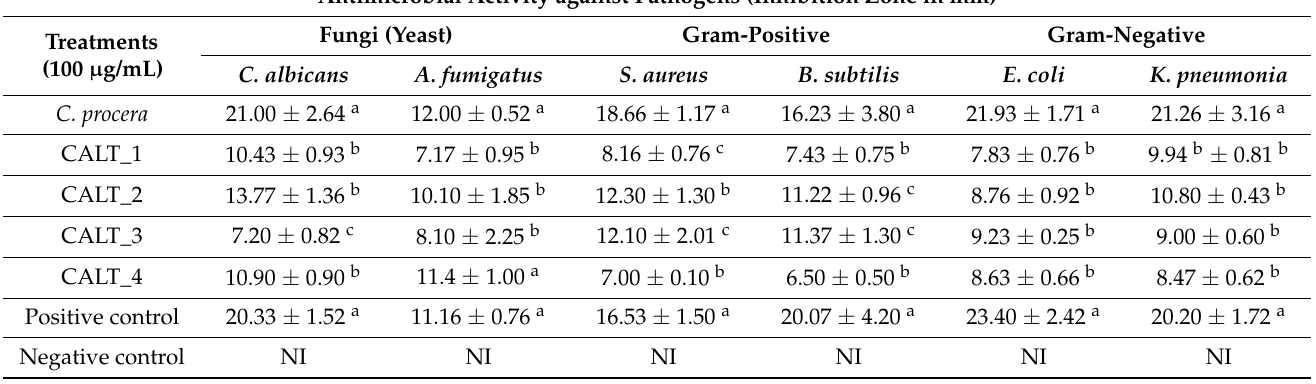
Table 1. Zone of inhibition (mm) of ethanolic extract of C. procera leaves and rhizosphere-inhabiting actinobacterial isolates against pathogens tested using agar well-diffusion assay. Antimicrobial Activity against Pathogens (Inhibition Zone in mm) Treatments